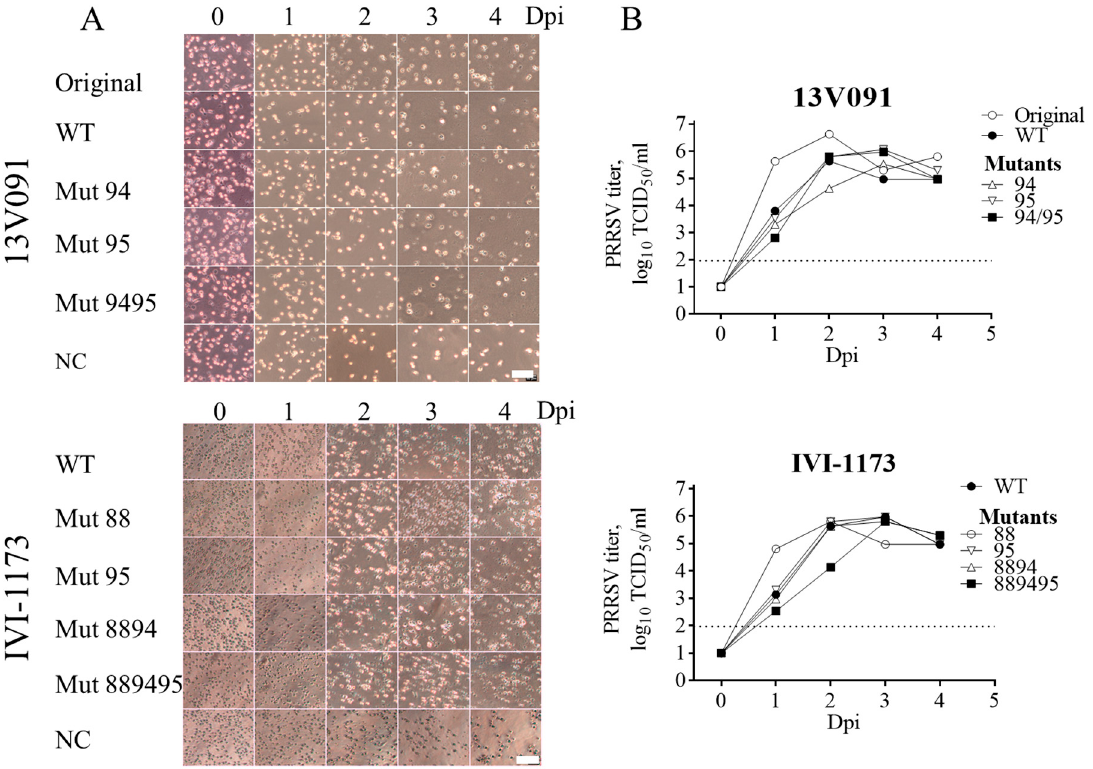
Figure 3. ( A ) Cytopathic effects (CPE) in PAM cells at 0–4 days post inoculation with the original 13V091 or rescued virus from the infectious clones (WT) and mutants of strains 13V091 and IVI-1173. Scale bar = 100 µ m ( B ) Virus replication kinetics in PAM. The dotted line represents the limit of detection for the assay.